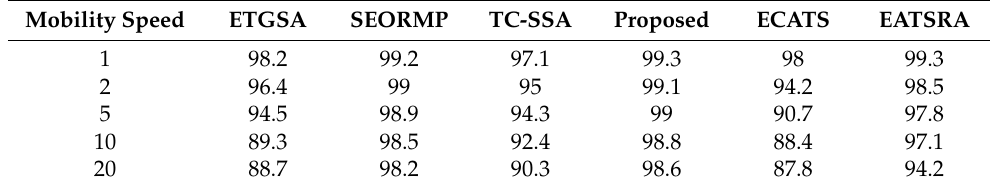
Table 6. Comparativeanalysisofthetransmissionrateofapacketconcerningspeedamongvariousmethods. Mobility